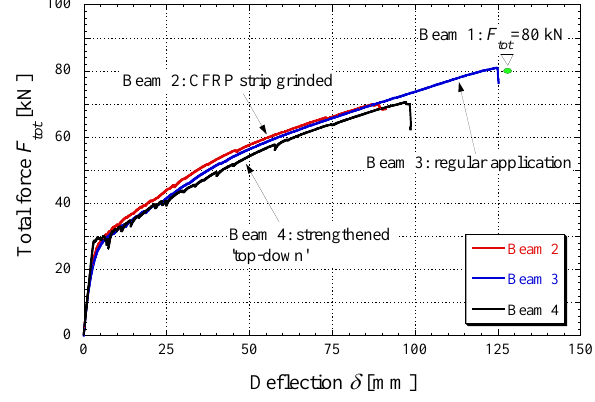
Figure 6. Total force-midspan deflection curve of all the performed static